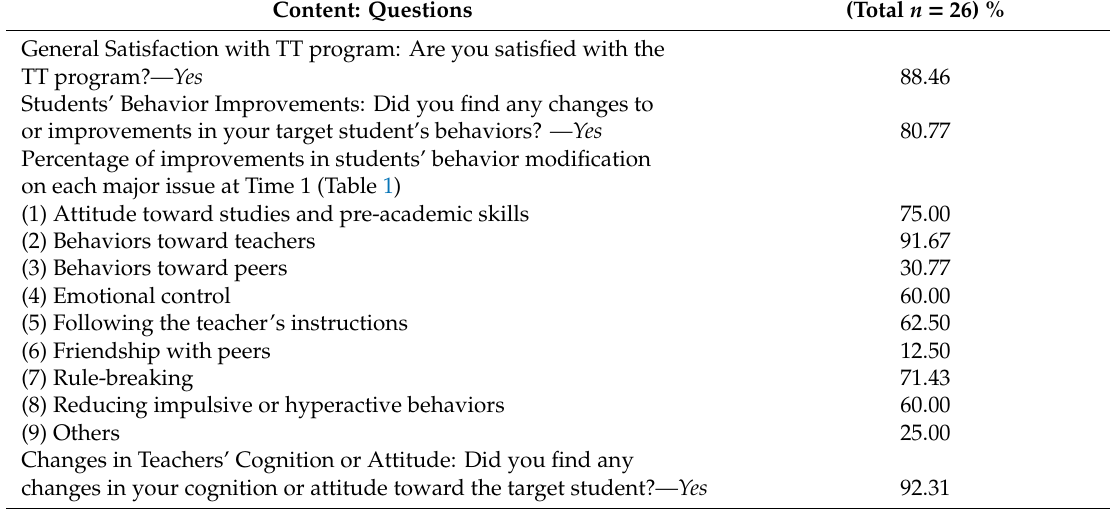
Table 6. Semi-structured interview results of teachers at Time 2 (IT group, n = 13) and Time 3 (DTC group, n = 13; 1 missing